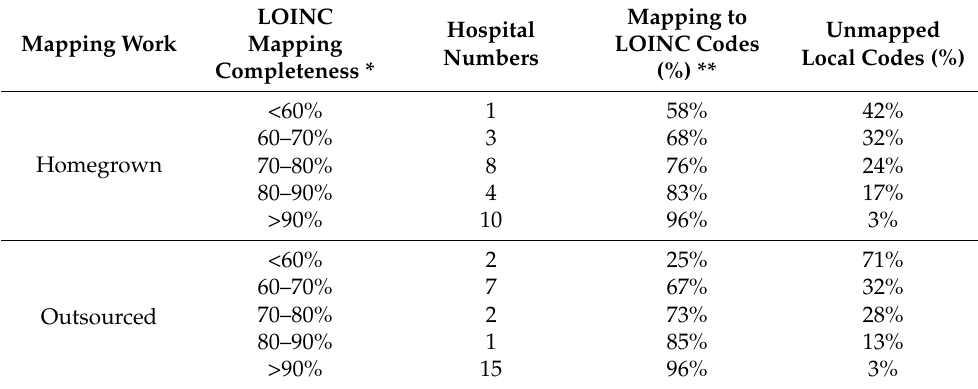
Table 2. Performance of LOINC mapping in homegrown and outsourced systems.